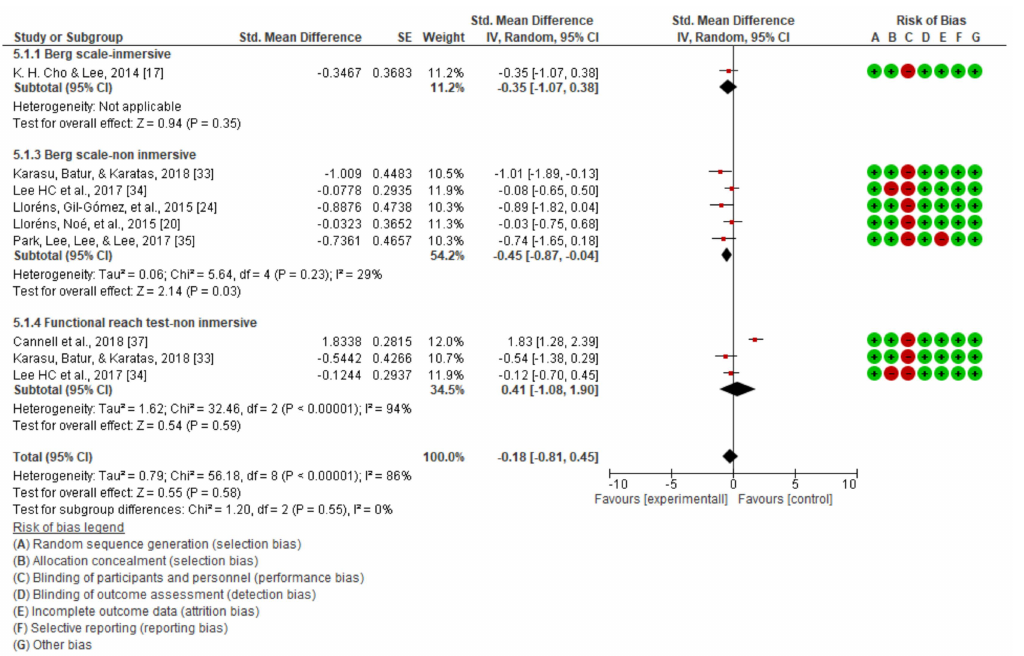
Figure 5. Global results for static